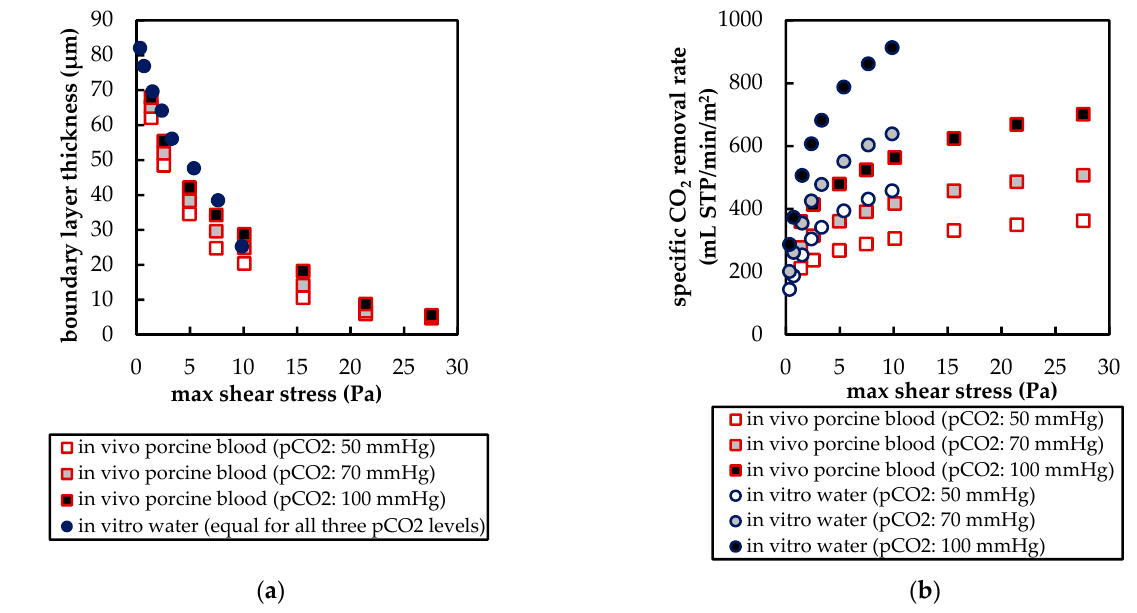
Figure 18. Influence of maximum shear stress on: ( a ) boundary layer thickness; ( b ) specific CO 2 removal rate.